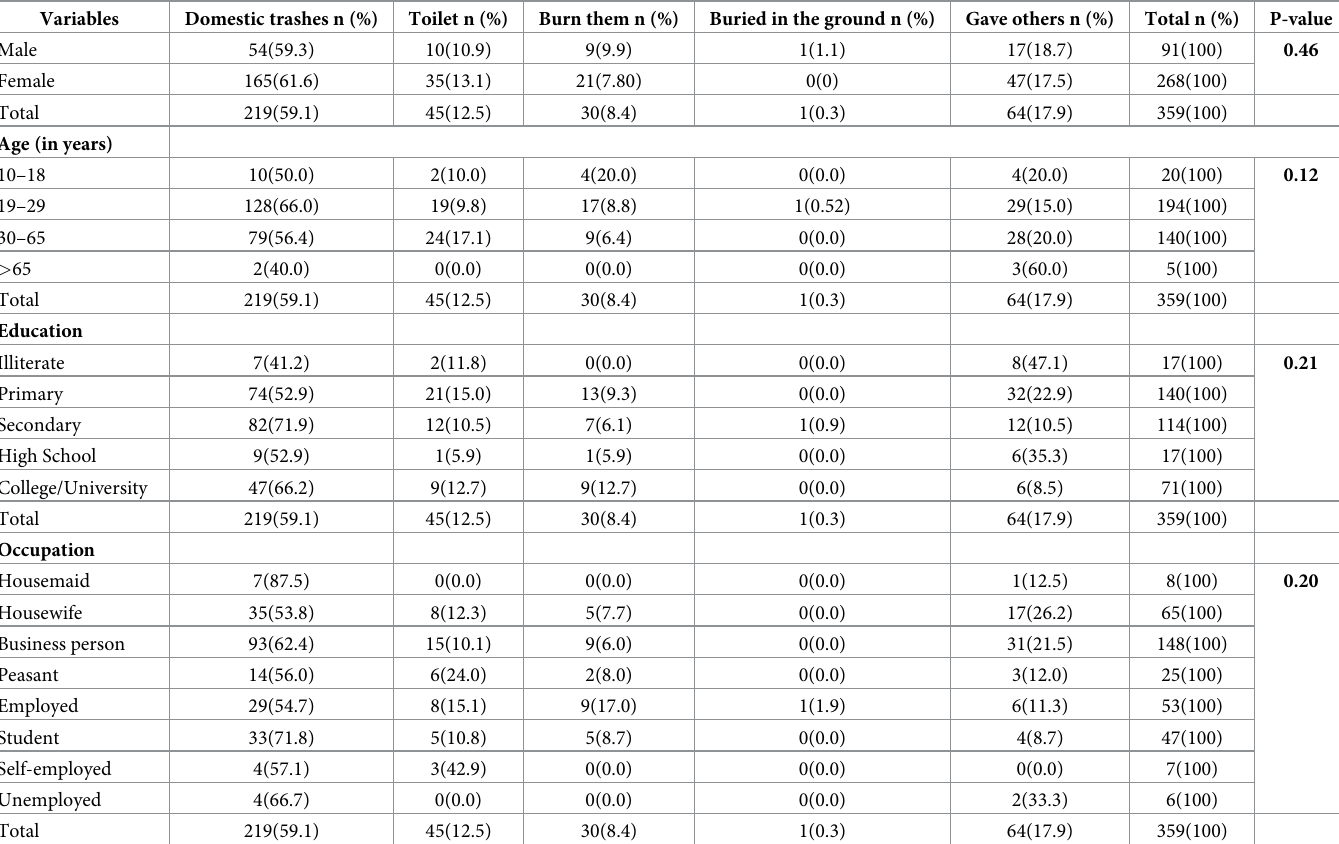
Table 2. Socio- demographic characteristics of the respondents and their drugs disposal practices at households.